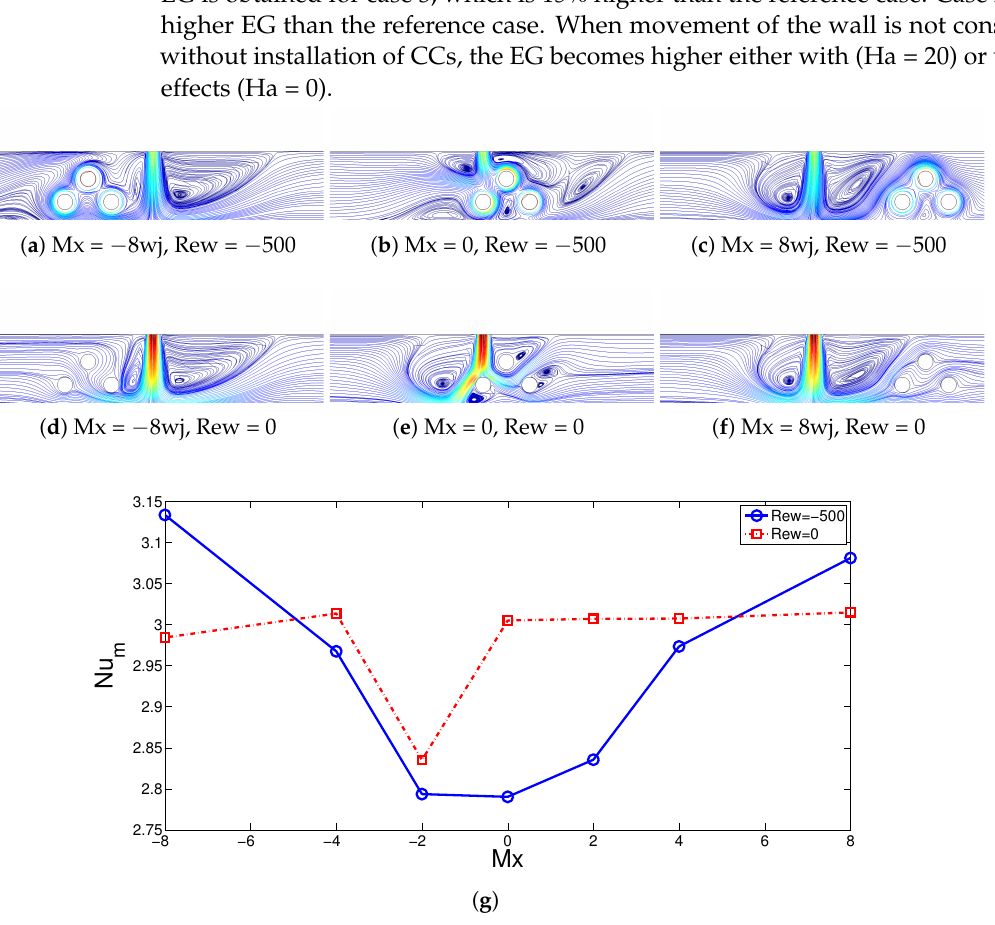
Figure 9. Variations of streamlines with changes in the horizontal location of the multiple CCs consider- ing rotational ( a – c ) and stationary ( d – f ) cases of CCs and impacts of horizontal location of CCs on the variation of average Nu considering rotating and non-rotating CC cases ( g ) (Ha = 5, Mx = − 1).